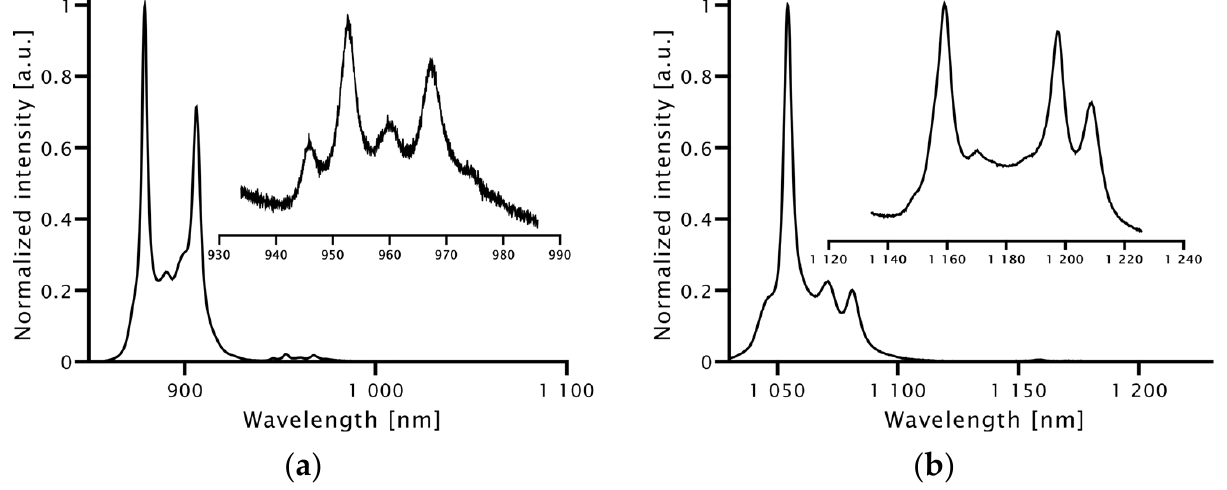
Figure 2. Normalized emission spectra of [Nd( L1 ) 3 Cl 3 ] 2 ( 2 ) obtained from amorphous bulk material at room temperature (RT): ( a ) 4 F 3/2 → 4 I 9/2 transition and 4 F 5/2 , 2 H 9/2 → 4 I 11/2 (inset). ( b ) 4 F 3/2 → 4 I 11/2 transition and 4 F 5/2 , 2 H 9/2 → 4 I 13/2 (inset).